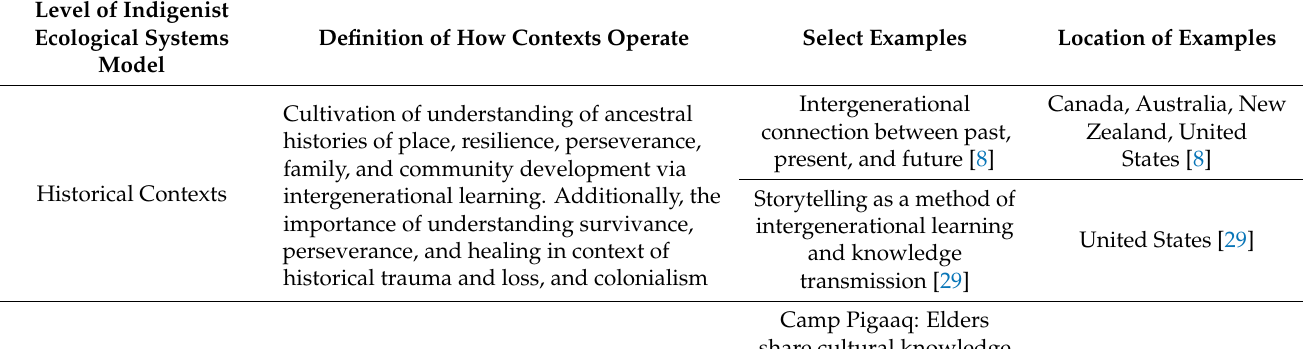
Table 1. Indigenist Ecological Systems Model description of levels and applied case